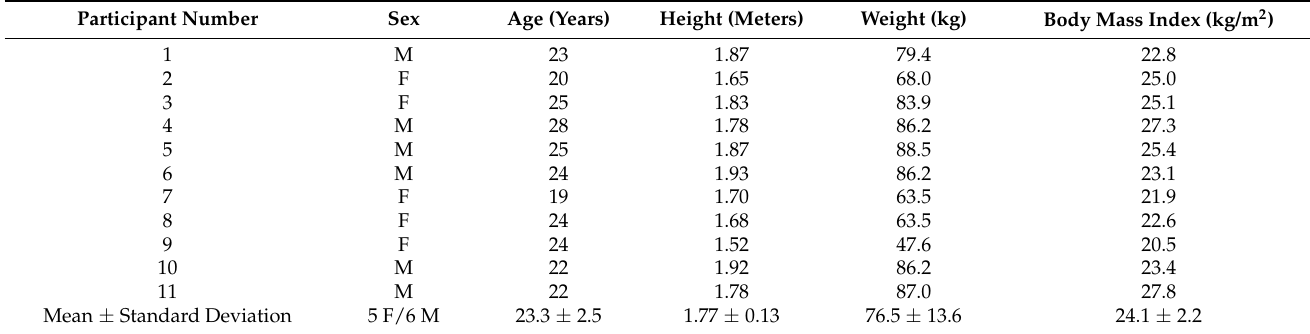
Table A1. Participant characteristics for the analyzed healthy young adults.